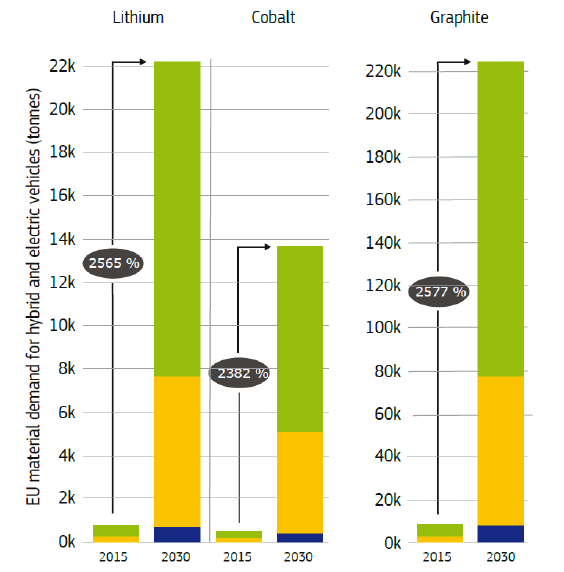
Fig. 3. Demand forecast in the EU for selected critical raw materials for the BEV, PHEV and HEV segments